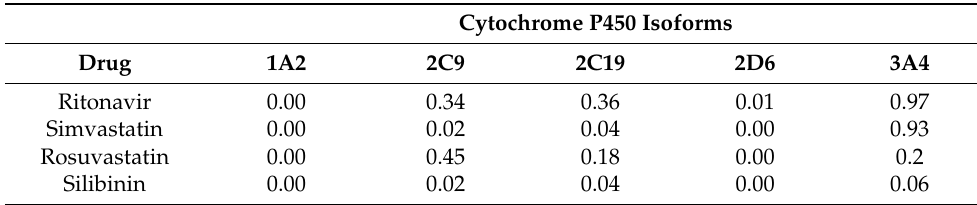
Table 3. Prediction of human cytochrome P450